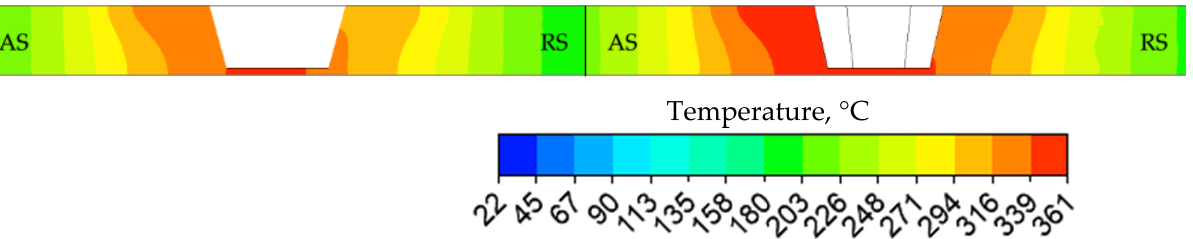
Figure 9. Temperature distribution for both FSW − C ( left ) and FSW − H ( right ), transverse section (according to the cross − section line in Figure 8).